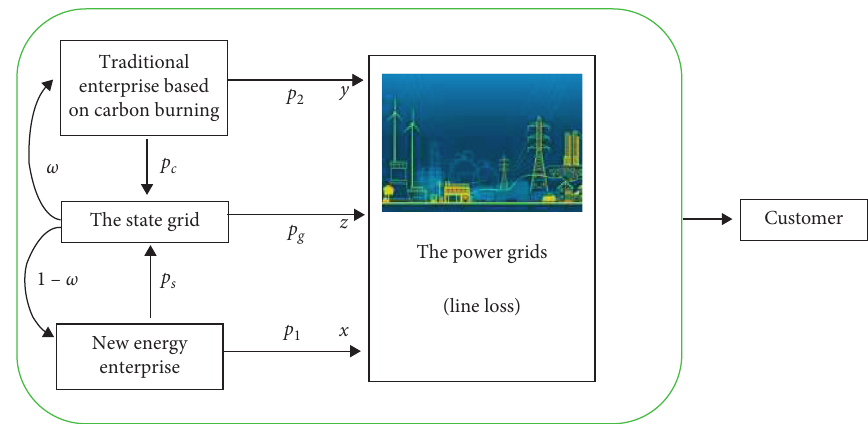
Figure 2: The model structure.